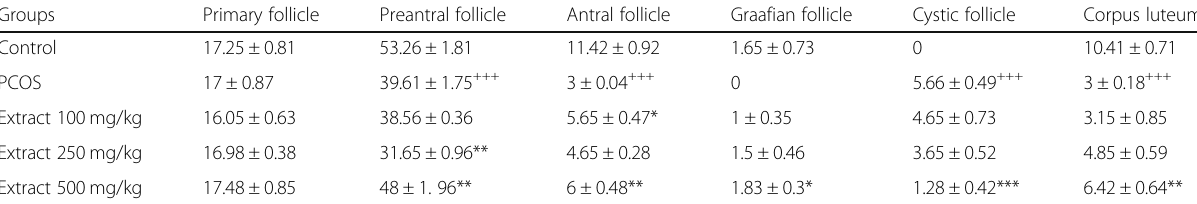
Table 2 Mean follicle numbers in different groups (mean ± SEM) Groups